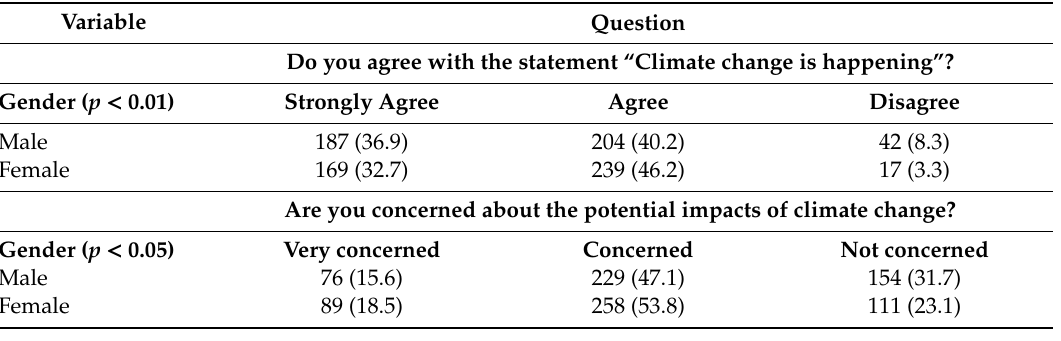
Table 3. Gender and perception of climate change-related risks among the general population in the Czech Republic, N (%).